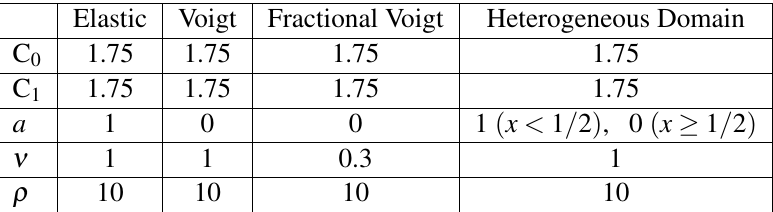
Table 6 The parameters used in the fractional Voigt model simulations to create the 2D spacetime plots shown in Figure